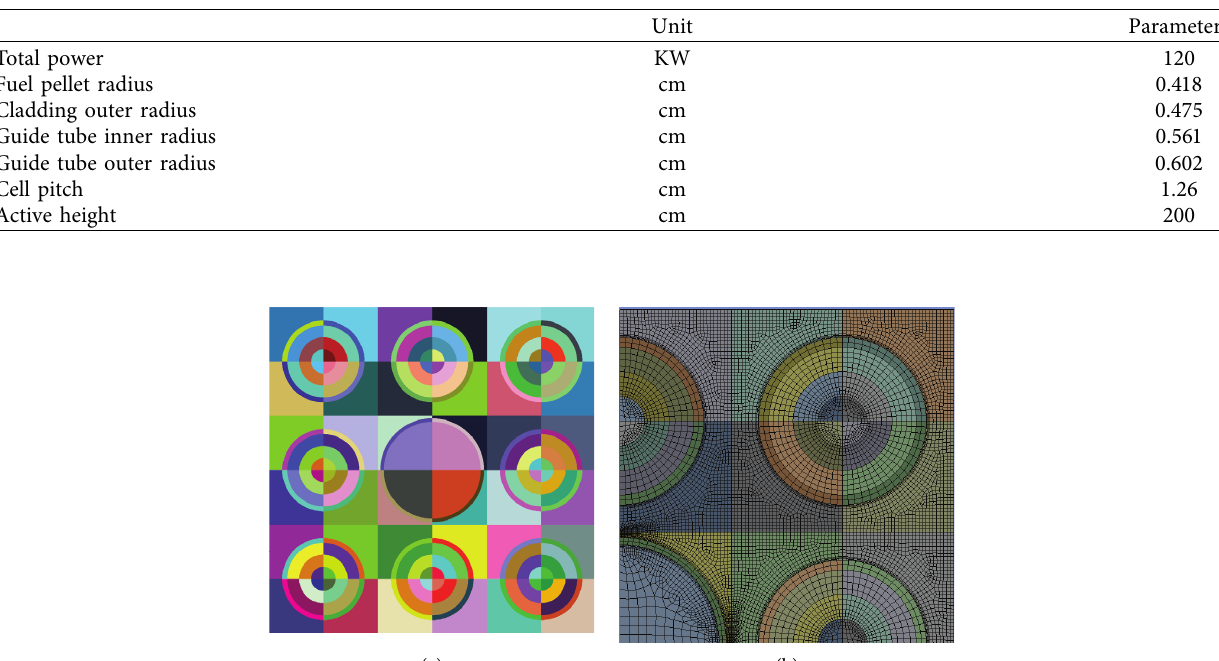
Figure 5: Schematic of the 3x3 fuel pins. Table 1: Parameters for 3x3 fuel pin model.